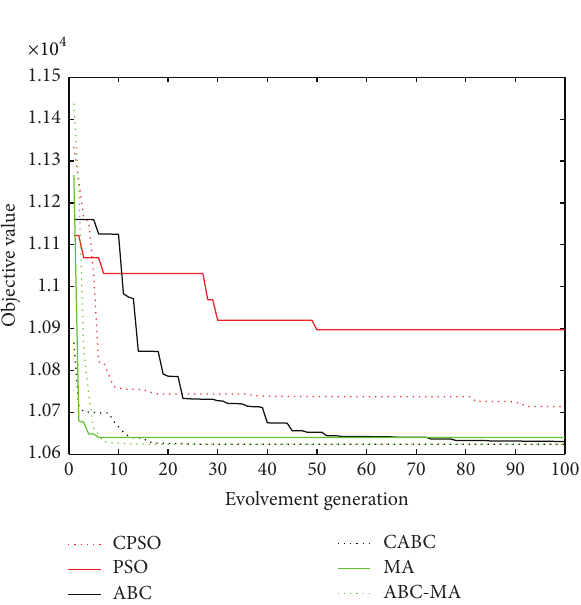
Figure 11: The convergence curve of the CMC data.